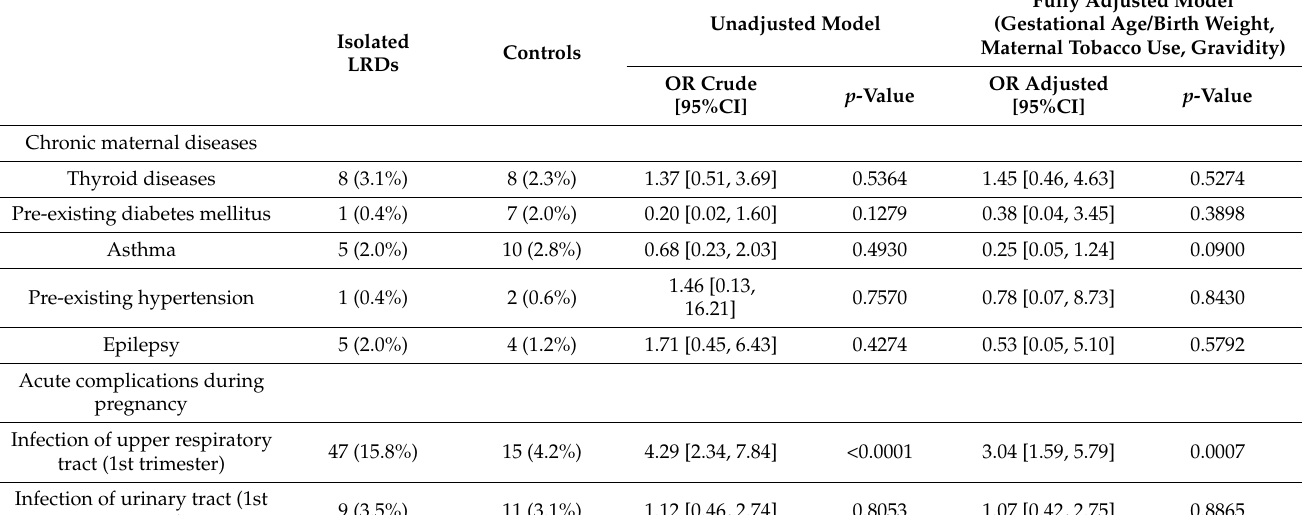
Table 3. Specific exposures during pregnancy and their associations with the risk of isolated LRDs. Fully Adjusted Model Unadjusted Model (Gestational Age/Birth Weight, Isolated Maternal Tobacco Use, Gravidity) Controls LRDs OR Crude OR Adjusted p -Value [95%CI]